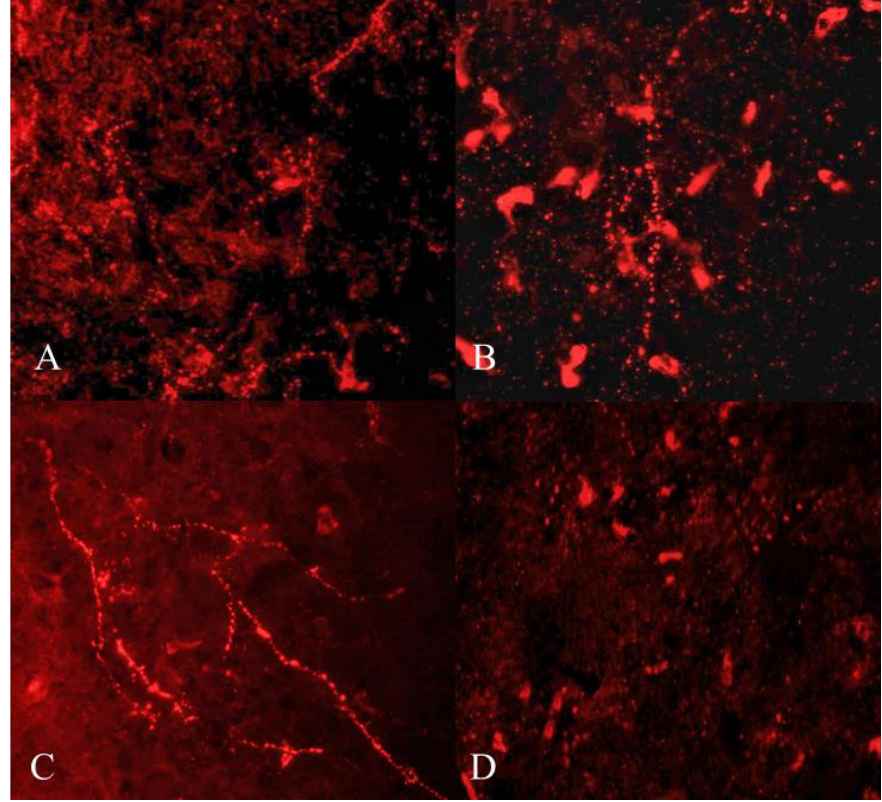
Figure 4. Representative photomicrographs showing GnIH-like immunoreactive terminal boutons and fibers in infant ( A ), juvenile ( B ), prepubertal ( C ), and adult ( D ) male rhesus monkeys.